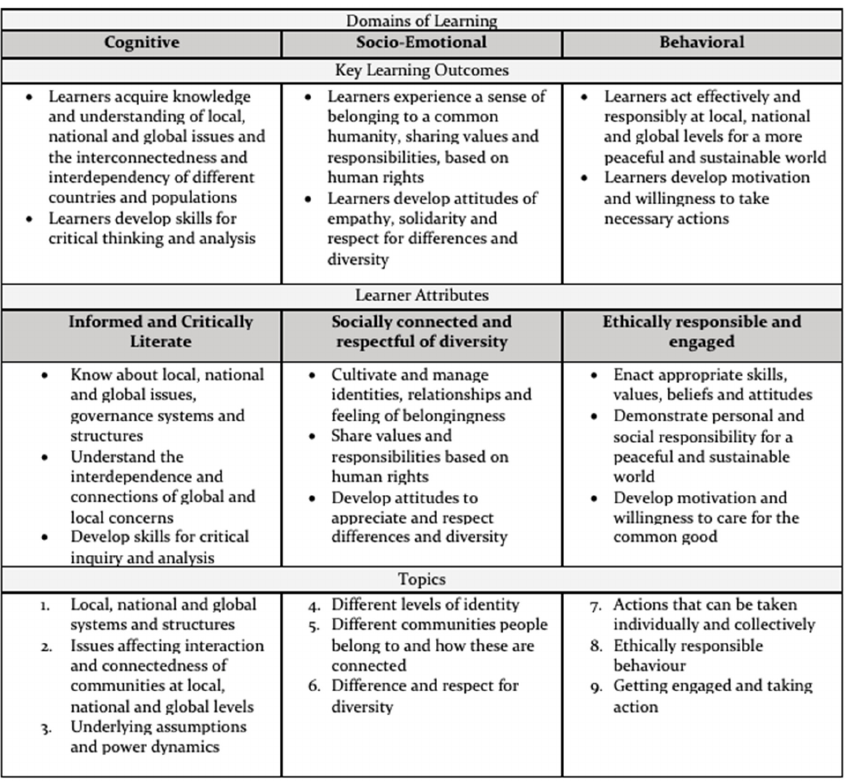
Figure 1. Copy of the framework by UNESCO [13].